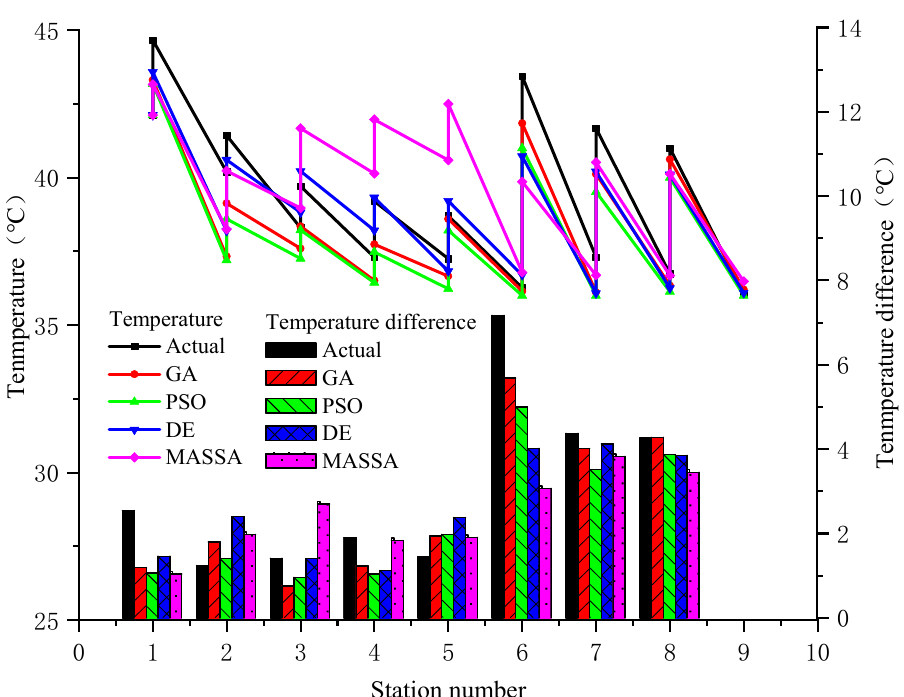
Figure 9. Temperature comparison between the actual scheme and the four algorithms’ simulation operation schemes.